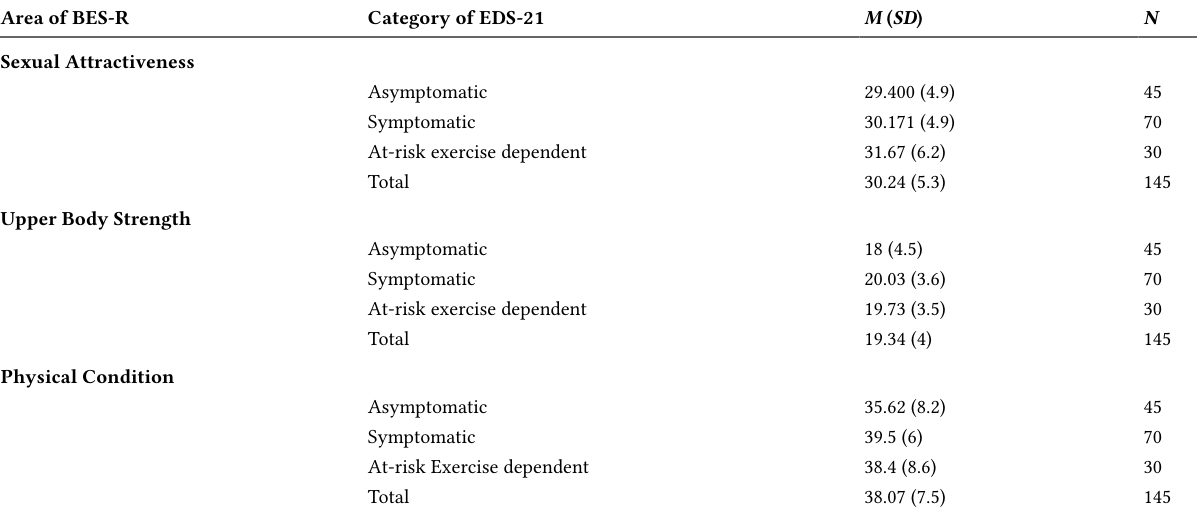
Mean, Standard Deviations and Sample Size for Male Gym-Goers Between Categories of Exercise Dependence and Areas of Body Esteem Area of BES-R